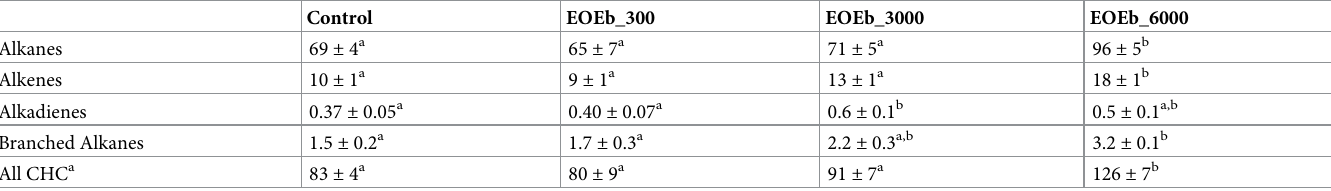
Table 3. Overall amounts of CHC from healthy honeybees (experiment I) fed on EOEb at different doses.